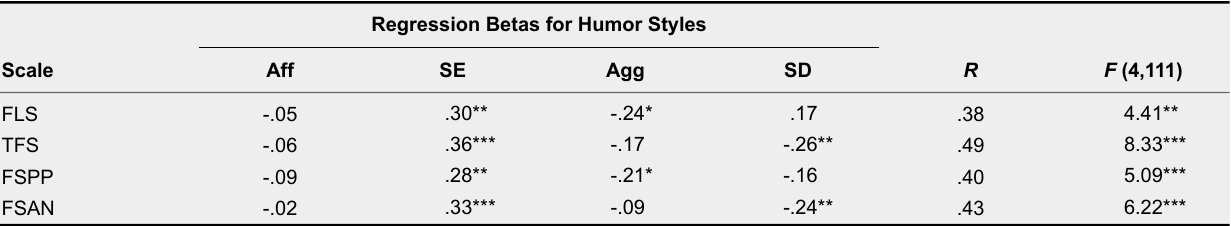
Multiple Regression Analyses With Scores Involving the Forgiveness Likelihood Scale and the Forgiveness Scale (Dependent Variables) and the Four Humor Styles (Predictor, Independent